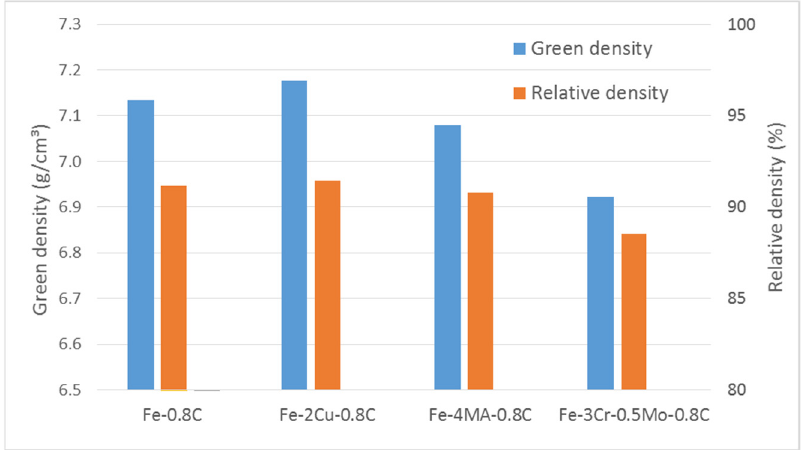
Figure 1. Green and relative density of steel powder mixes compacted at 600 MPa in lubricated die.